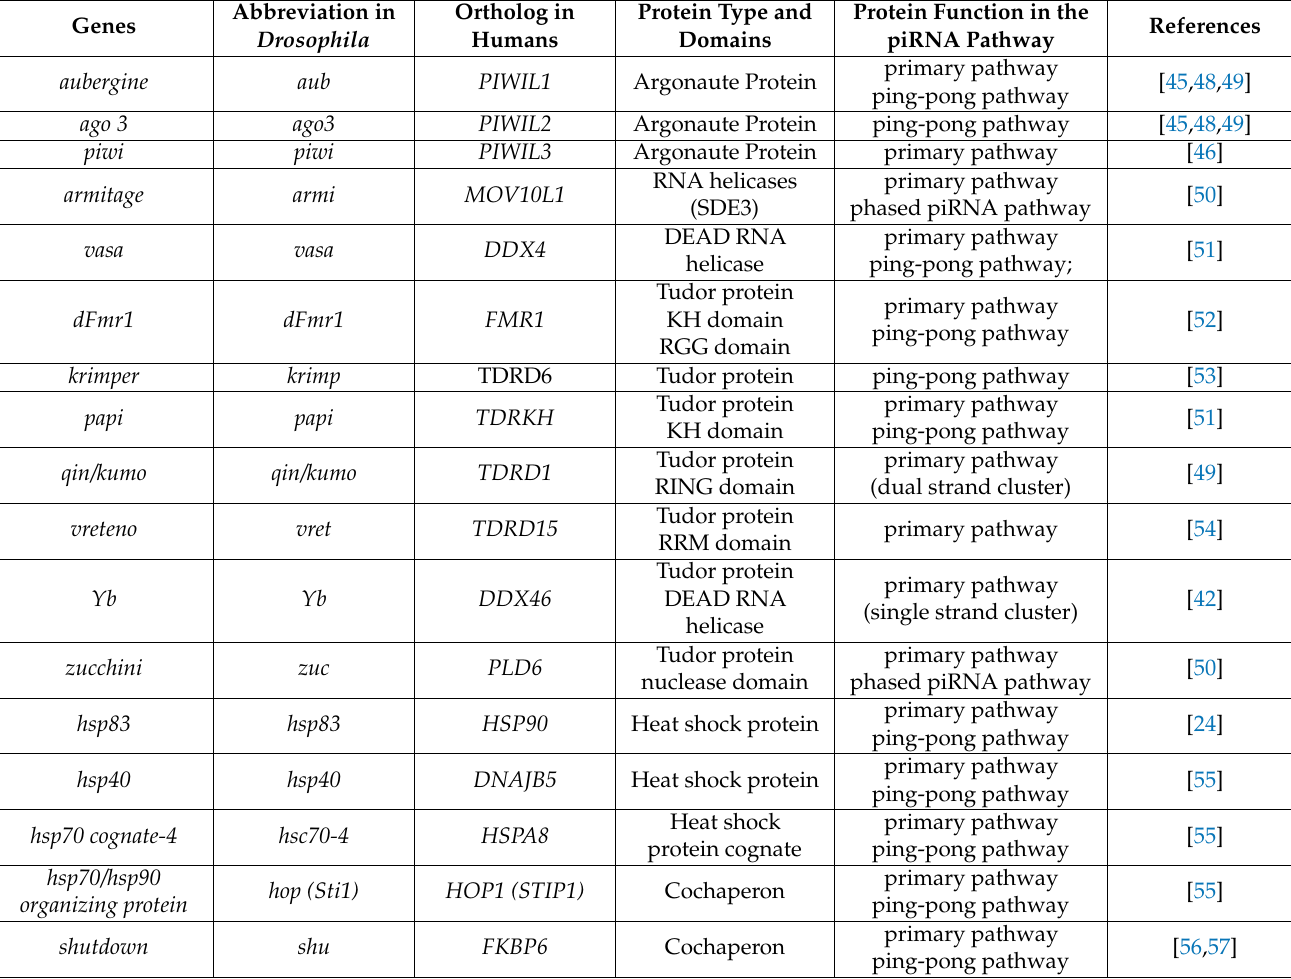
Table 1. List of genes involved in the piRNA pathway and reported in Figure 1, with the hortologs in humans, their protein domains, and functions. The references refer to the involvement of the reported genes in the piRNA